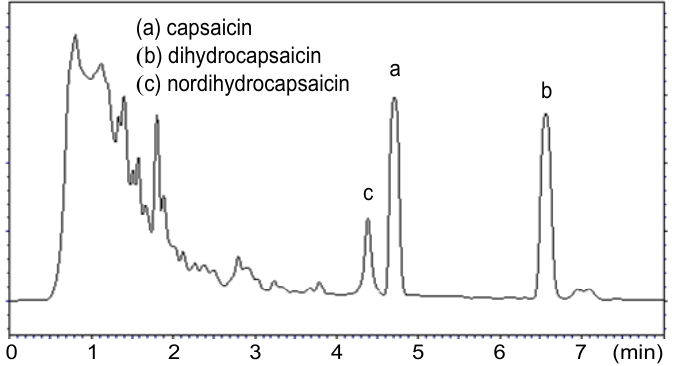
Figure 2. Chromatogram of the red chili extract (conditions: column Betasil C (150 × 4.6 mm × 3 μ m), mobile phase: H detection at 222 nm).